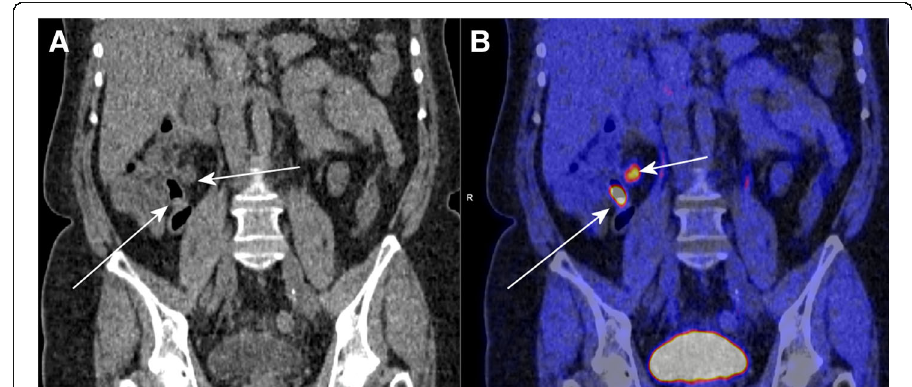
Fig. 1 After oral administration of 75 mg carbidopa, 300 MBq of 18 F-FDOPA was injected intravenously. Images were acquired 60 min after injection on a 64-slice PET/CT camera (mCT Biograph, Siemens Medical Solutions, Knoxville, TN USA,) whole body. Increased uptake was noted in the terminal ileum (left arrow) and in the mesentery (right arrow), as shown in figure 1 a (CT only) and 1 b (fused PET/CT images)